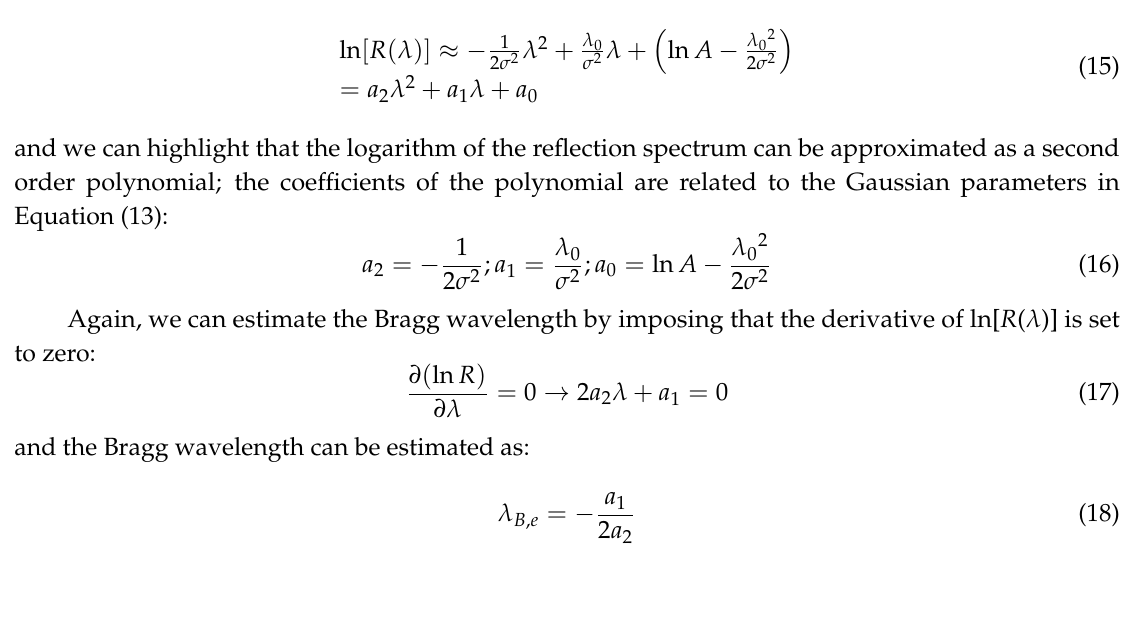
Figure 8. Sketch of the Gaussian → polynomial fitting peak tracking method. ( The left chart ) shows the FBG spectrum, while ( the right chart ) shows the logarithm of the reflection spectrum and its second-order interpolation, zooming into the inner FBG spectral region.